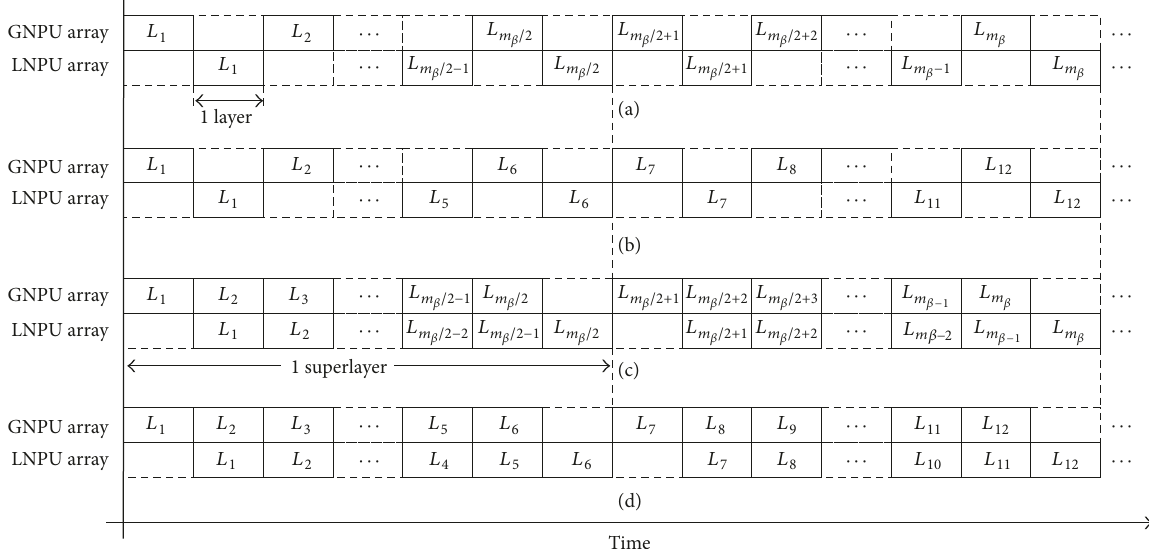
Figure 7: Layer-level view of the pipeline timing diagram. (a) General case for a circulant- 1 identity submatrix construction based QC-LDPC code(seeSection2)withoutpipelining.(b)Specialcaseofthe IEEE802.11n QC-LDPCcodeusedinthisworkwithoutpipelining.(c)Pipelined processing of two layers for the general QC-LDPC code case in (a). (d) Pipelined processing of two layers for the IEEE 802.11n QC-LDPC code case in (b). This schedule is illustrated by the layer processing loop in the high-level decoder architecture shown in Figure 9. Here, 𝑚 𝛽 represents the number of rows of 𝛽 󸀠 I